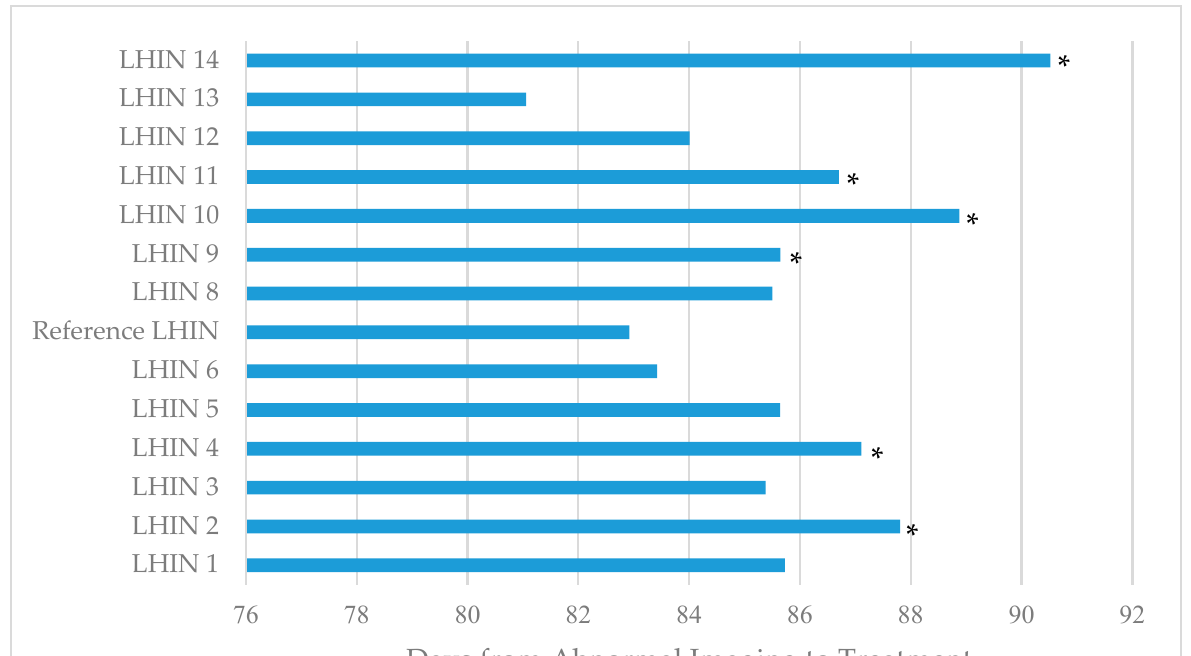
Figure 4. Timeliness of care from first abnormal imaging to LC treatment. This graph shows the average number of days from the first abnormal imaging to the first treatment (including radiation, surgery, or systemic therapy) for lung cancer across LHINs. *denotes significance by pairwise t -tests for each of the LHINs compared to LHIN 7, using Šid á k correction for multiple comparisons, p < 0.05. There was also variation amongst LHINs with respect to the number of radiation oncology (RO) and medical oncology (MO) visits prior to treatment initiation, or in the 90 days after diagnosis if the patient did not receive treatment. This ranged from an average of 0.42 RO visits/patient in LHIN 4-Hamilton Niagara to 0.71 RO visits/patient in LHIN 10-South East. The visits with MO also varied from 0.17 visits/patient in LHIN 4-Hamilton Niagara to 0.5 visits/patient in LHIN 5-Central West. Assessment by RO was associated with worse survival (HR 1.28, p < 0.0001), while assessment by MO was associated with improved survival (HR 0.94, p < 0.0001) (Table 3). to the nearest hospital, stage, histology, co-morbidity status, timeliness of care, and spe- cialist assessment, there was less variability across LHIN and improvement in the survival estimate for several LHIN in the adjusted analysis. Even still, there remained a signifi- cant difference in survival in the adjusted analysis for several LHINs compared with the reference LHIN (Figure